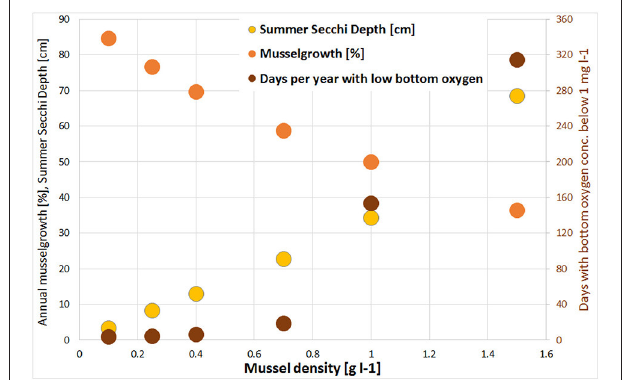
FIGURE 7 | Change of annual potential mussel growth (harvest divided by mussel biomass; orange); and increase of Summer Secchi Depth [cm; yellow] and days per year with bottom oxygen concentration below 1mg l − 1 [brown] for different mussel densities in the large scale mussel farm option. Always in relation to the simulation without